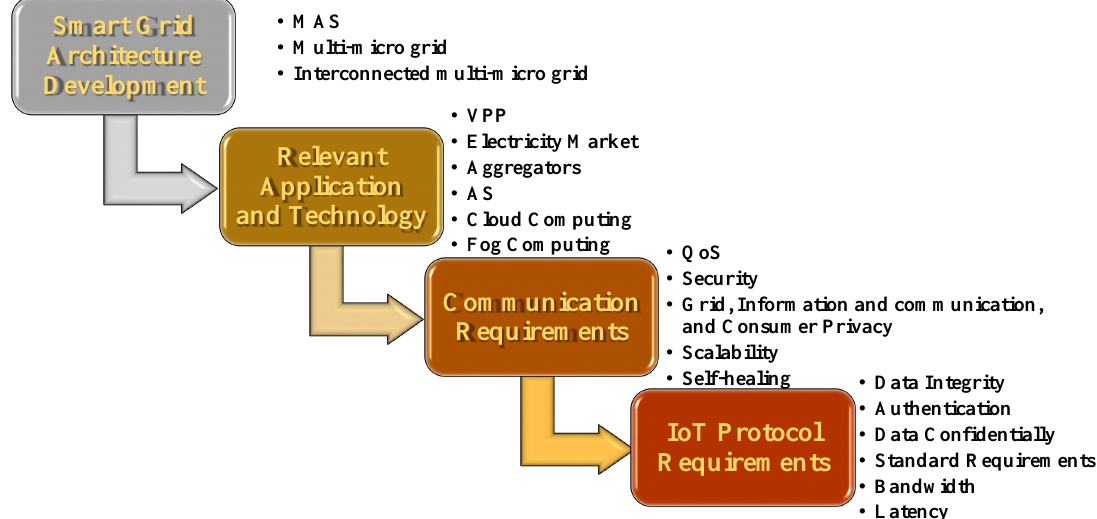
Figure 8. Effective elements in application of IoT in the smart grid future